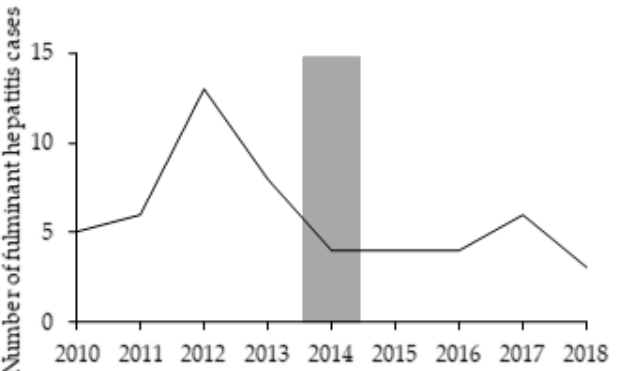
Figure 4. Overall fulminant hepatitis cases reported between 2010 and 2018. Grey bar represents the year of hepatitis A vaccine introduction (transition period). Table 5. Fulminant hepatitis number of cases and incidence during the period of the study.